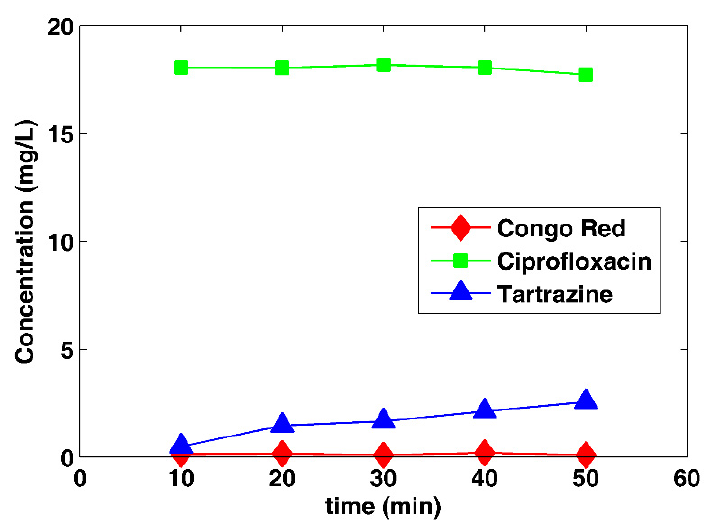
Figure 4. Pollutant concentration in permeate as a function of time for membrane M1.